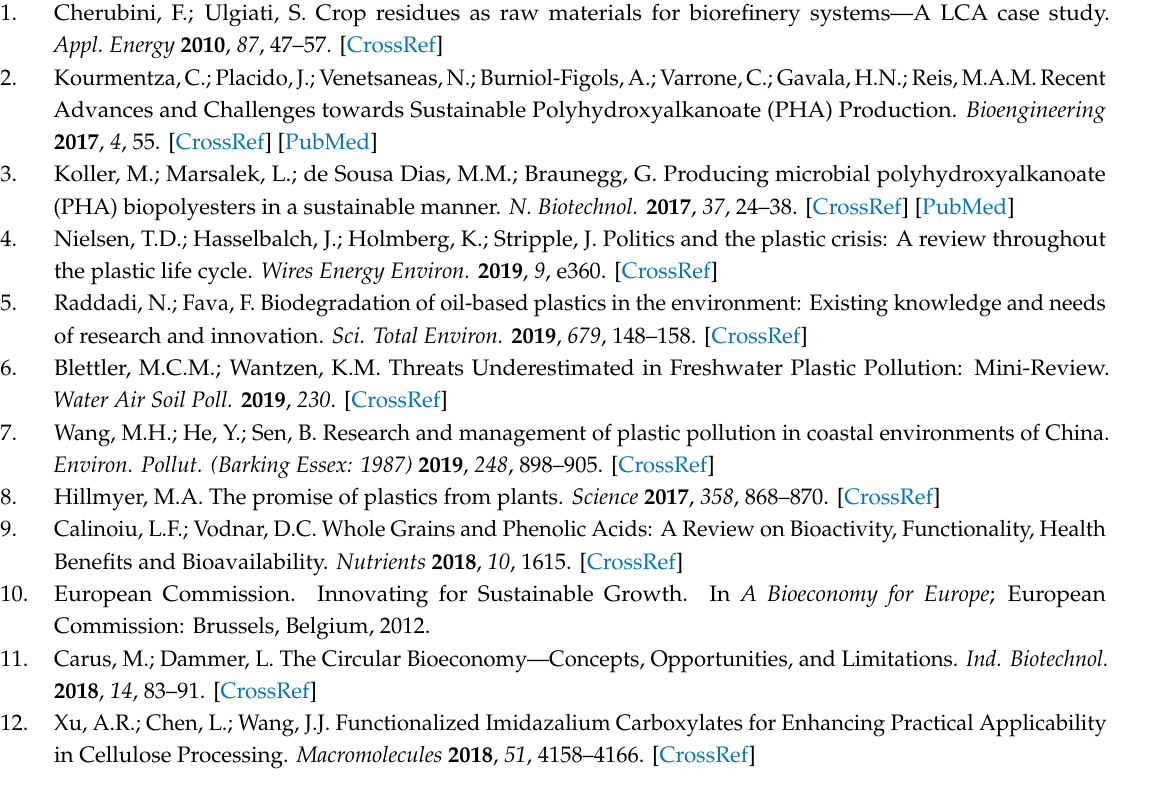
Table S1: Shear viscosity and shear stress of biofilms at 37 ◦ C temperature with standard deviation. Table S2: Shear viscosity and shear stress of biofilms at 30 ◦ C temperature with standard deviation. Table S3: Shear viscosity and shear stress of biofilms at 21 ◦ C temperature with standard